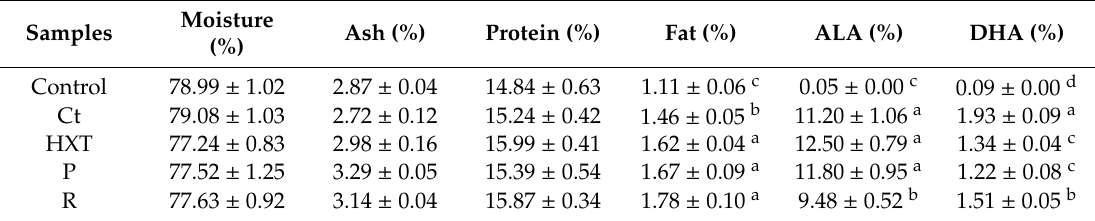
Control: 200 ppm acerola + 200 ppm citric extract (Ct); 200 ppm acerola + 200 ppm hydroxytyrosol extract (HXT); 200 ppm acerola + 200 ppm pomegranate extract (P); 200 ppm acerola + 200 ppm rosemary extract (R). α -linolenic acid (ALA); docosahexaenoic acid (DHA). The results of ALA and DHA content were expressed as percentage of methyl esters of each fatty acid of the total fat percent. Mean ± standard error (M ± s.e.). Di ff erent letters in the same column (a, b, c, d) indicate significant di ff erences between samples ( p <